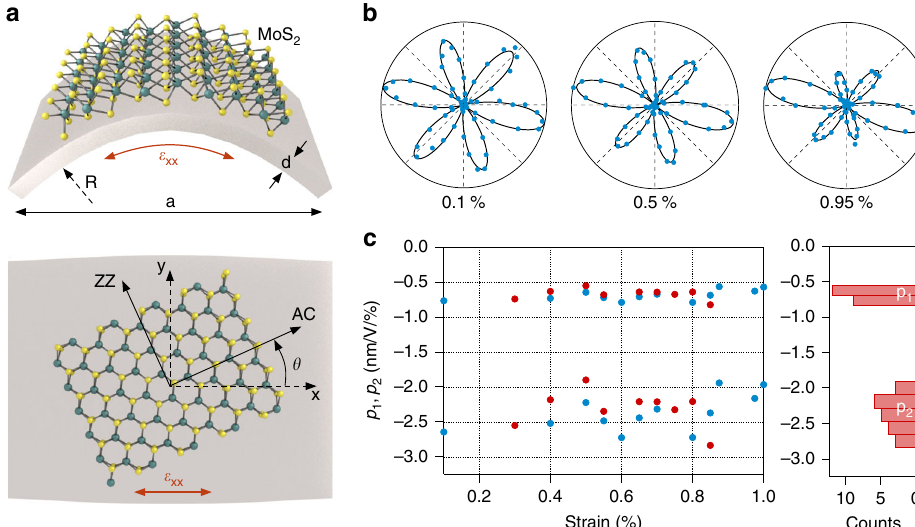
Fig. 3 Photoelastic parameters. a Schematic illustration of two-point bending method (top: side view; bottom: top view). AC armchair direction, ZZ zig-zag direction. b SHG patterns for applied tensile strains of 0.1, 0.5, and 0.95%. (symbols: measurement data; line: fi t) c Photoelastic parameters p 1 and p 2 for monolayer MoS 2 as determined from measurements on two different samples (plotted in different colors). Left panel: strain dependence; right panel: histogram of measurement